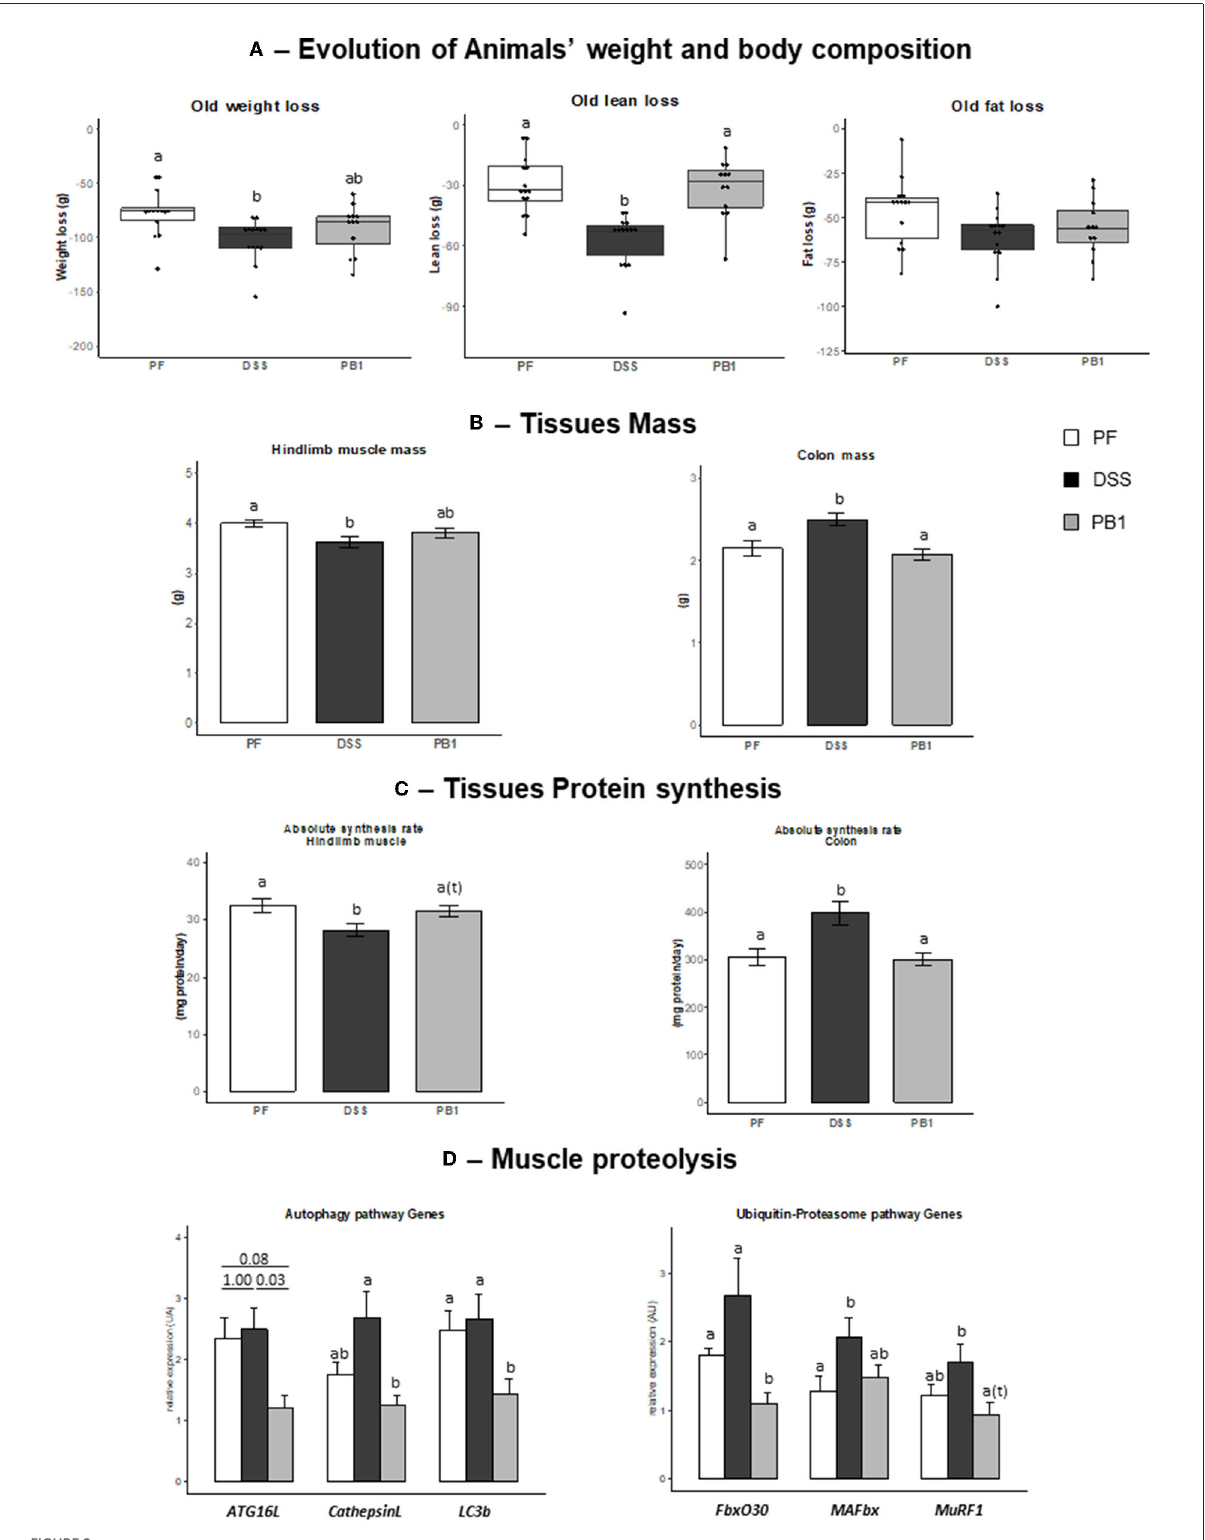
FIGURE2 Impact of Dextran sodium sulfate with (PB1) or without probiotic supplementation (DSS) on colon and muscle physiology/protein metabolism in adult older rats. (A) Evolution of rats weight (g), lean mass (g) and fat mass (g), (B) Evolution of hindlimb and colon masses (g), (C) Evolution